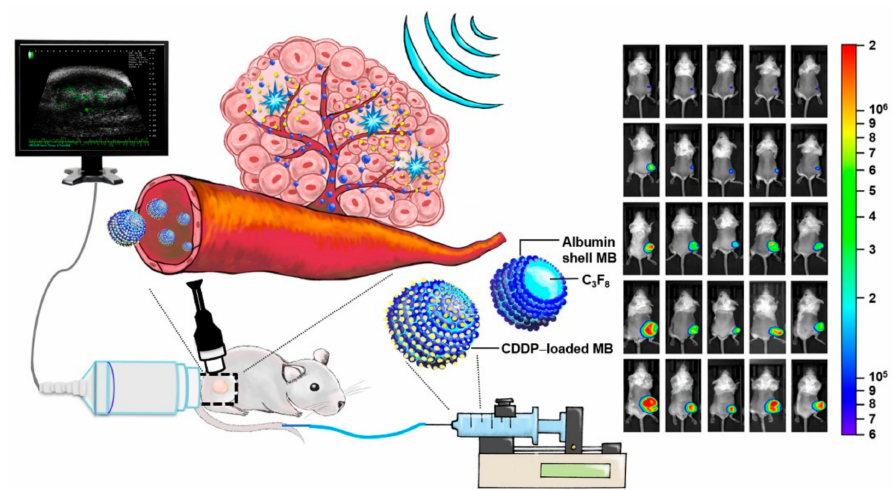
Figure 6. A working model of the gas-filled and CDDP-carrying MBs for the application of USMB in head and neck cancer systemic